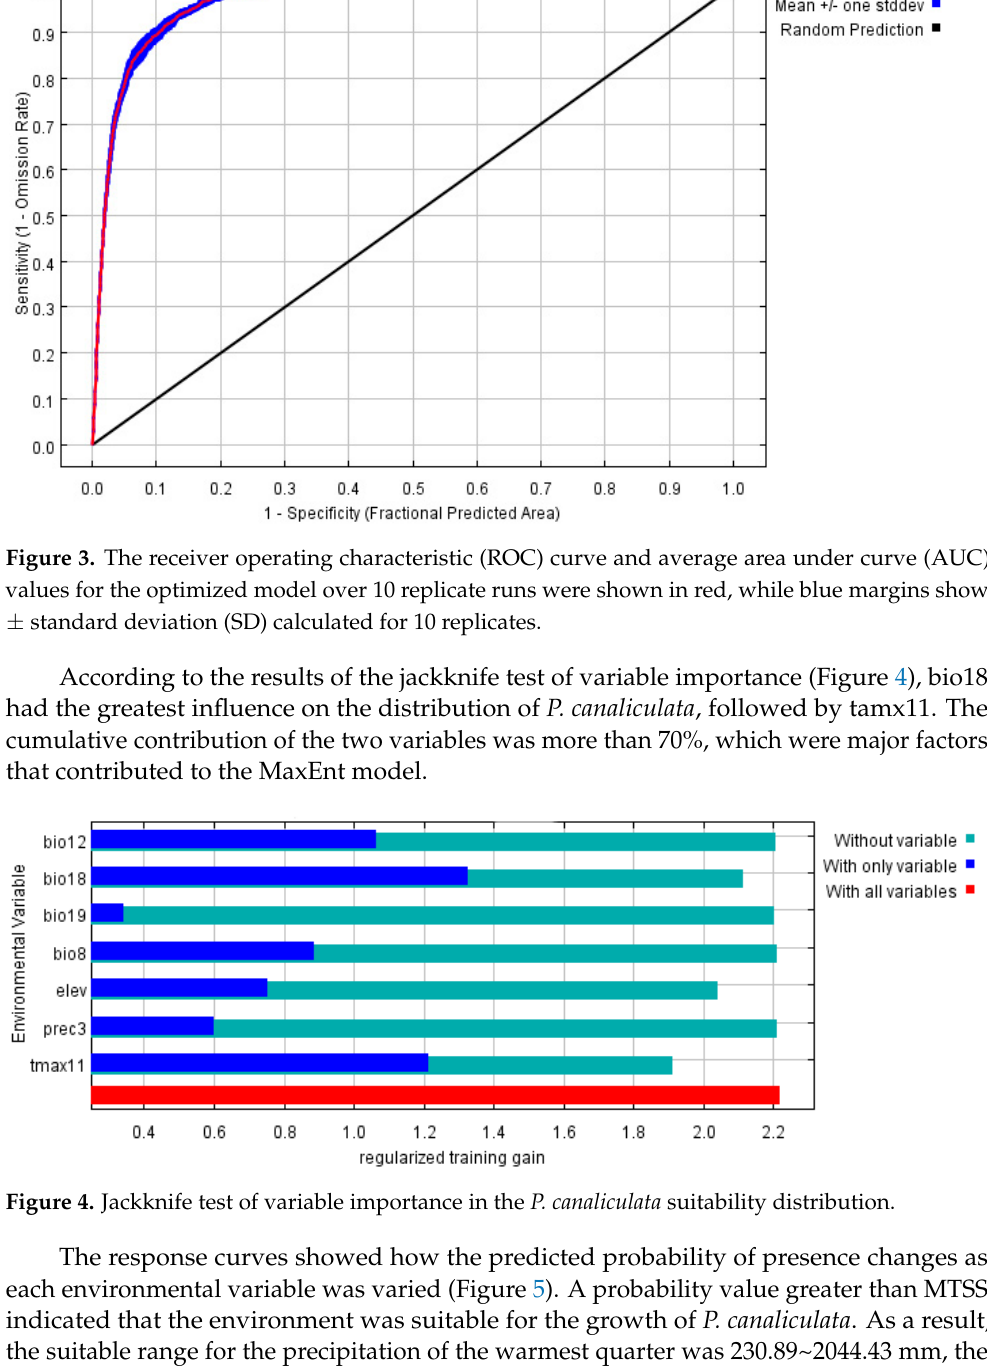
Figure 2. MaxEnt model predicted the current potential habitat suitability of Pomacea canaliculata in China. The base map was obtained from the Ministry of Natural Resources of China